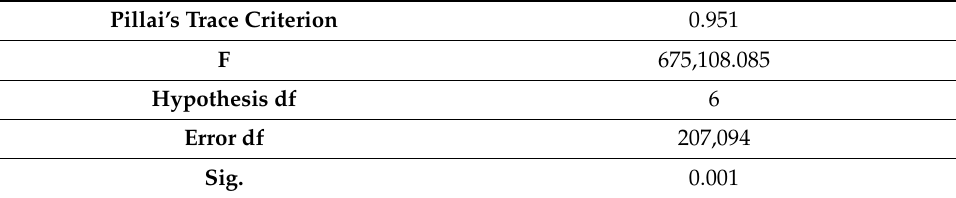
Table 6. Summary of the results of Pillai’s Trace of Equality of Covariance Matrices of Canonical Discriminant Functions.